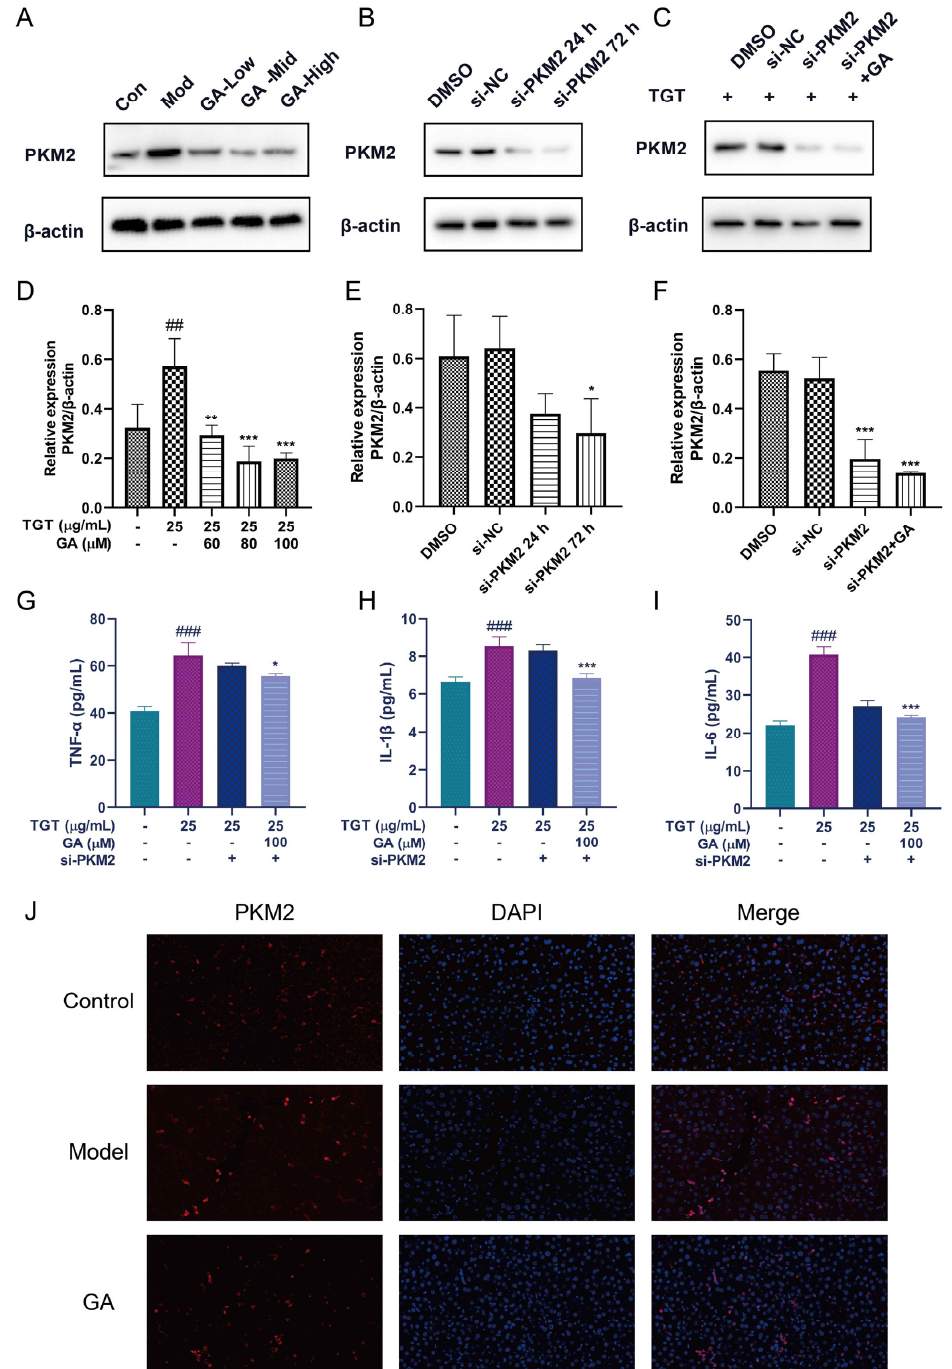
Figure 5. Silencing of PKM2 could inhibit inflammation. ( A ) The expression of PKM2 was detected by WB; ( B ) cells transfected with siRNA for 24 h or 72 h (si-PKM2); ( C ) TGT-induced cells transfected with si-PKM2 72 h with or without GA; ( D – F ) the results were analyzed by WB. Data are expressed as the mean ± s; ## p < 0.01, ### p < 0.001 vs. control; * p < 0.05, ** p < 0.01, *** p < 0.001 vs. model or DMSO, n = 3; ( G – I ) the levels of TNF- α , IL-1 β and IL-6 in si-PKM2-transfected cells treated with TGT or GA, n = 3; ( J ) localization of PKM2 (red) verified by immunofluorescence staining (40×).